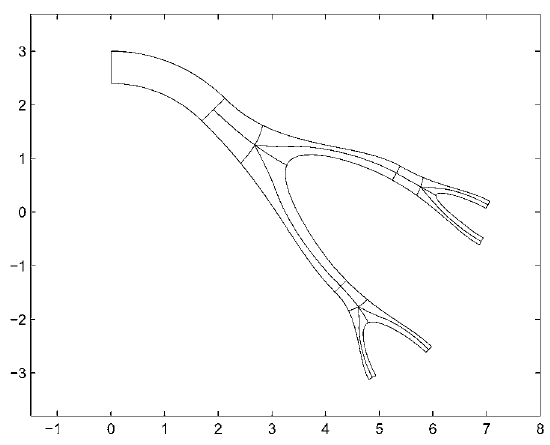
Figure 1. A hierarchical flow system with one pipe-block and three